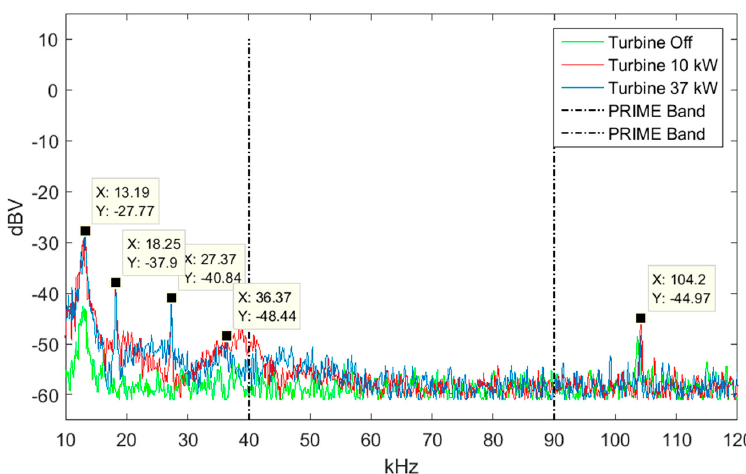
Figure 5. Spectrum recorded at the turbine SM in steady operation for different values of power.